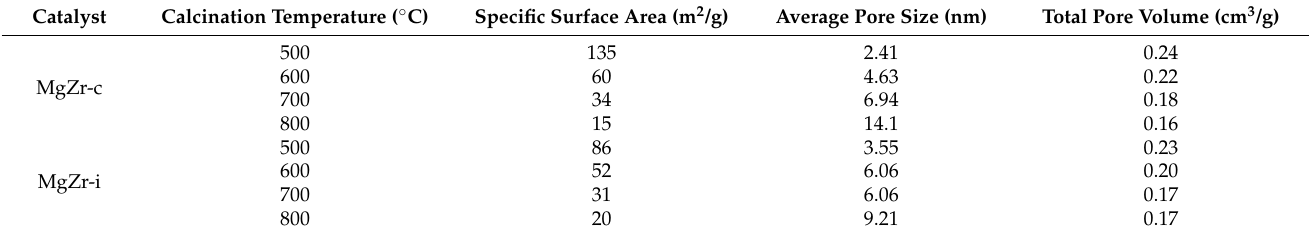
Table 3. Specific surface area, average pore size, and total pore volume of the solid base MgZr.